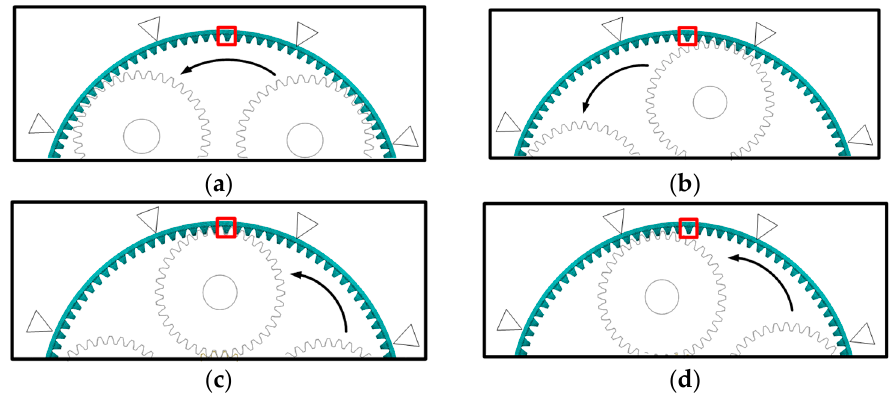
Figure 21. ( a ) State 1. ( b ) State 2. ( c ) State 3. ( d ) State 4.